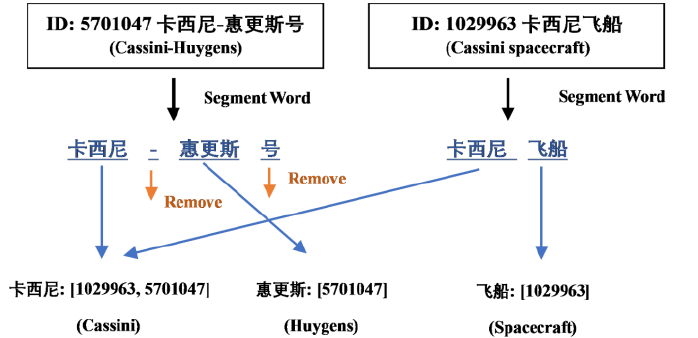
Figure 5. An example of the process of generating the word segmentation dictionary. (Words “ 卡 西 尼 - 惠 更 斯 号 ” (Cassini–Huygens) and “ 卡 西 尼 飞 船 ” (Cassini Spacecraft) are entities stored in the knowledge base. The [1029963, 5701047] is the ID set of the segemented word “ 卡 西 尼 ” (Cassini), and so